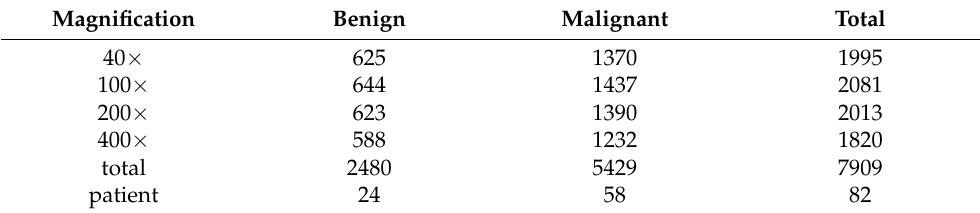
Table 1. Image distribution of different magnifications in BreakHis